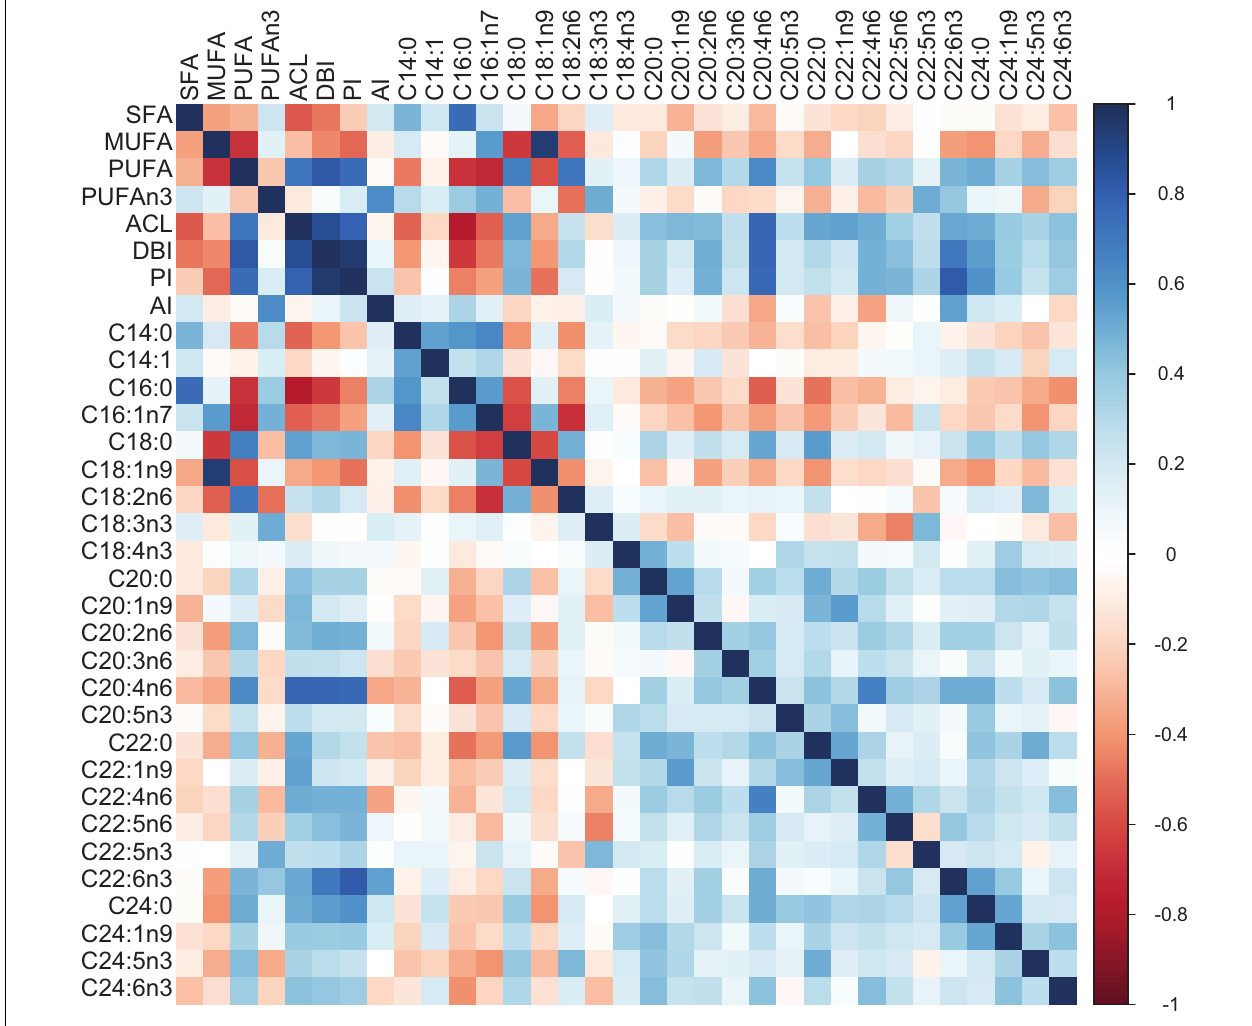
FIGURE 2 | Pairwise correlations between residuals of FA indices and individual FA. Correlations were calculated using residuals from phylogenetic generalised least squares regression on body mass. The proportional variables were logit-transformed, and AI was log-transformed before the analysis. SFA – saturated fatty acids, MUFA – monounsaturated fatty acids, PUFA – polyunsaturated fatty acids, DBI – double bond index, PI – peroxidizability index, ACL – average chain length, AI – anti-inflammatory